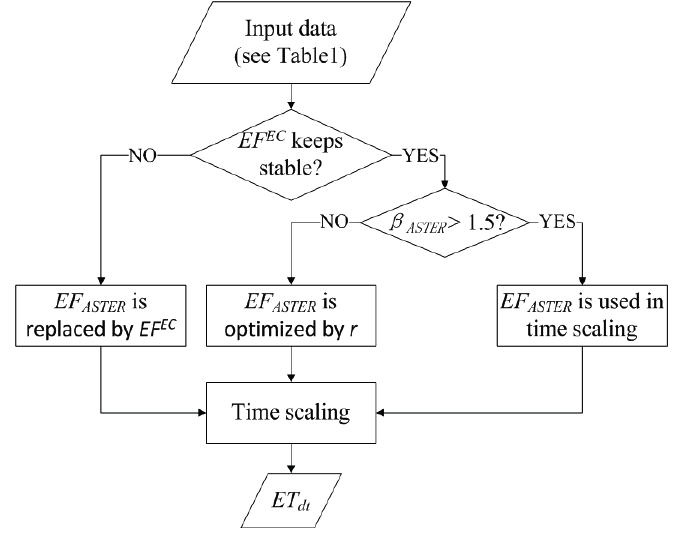
Figure 3. Flowchart of the revised temporal scaling